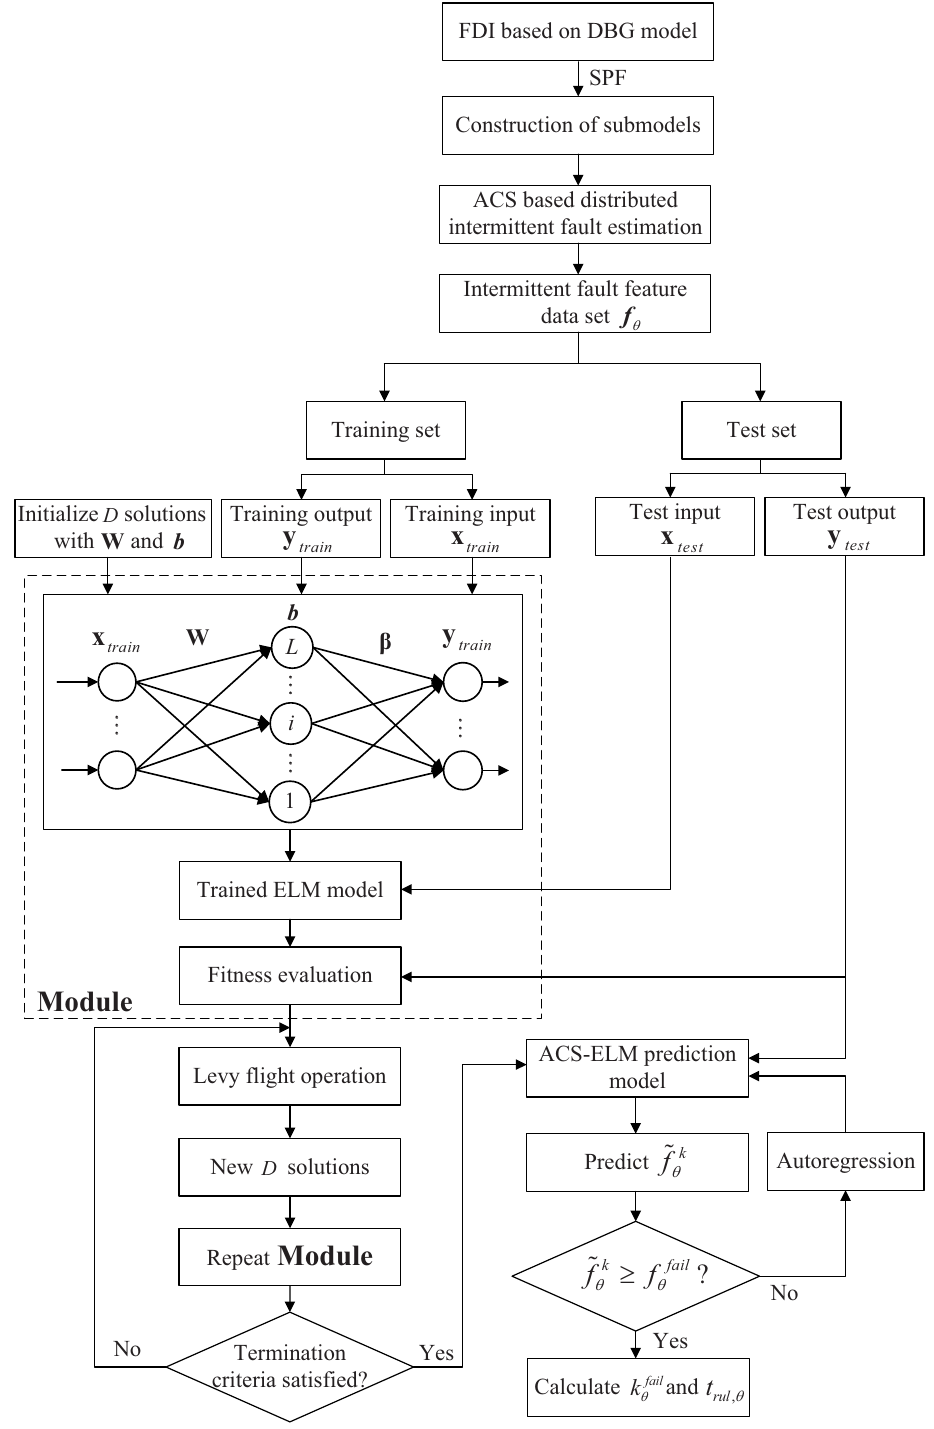
Figure 4. The framework of ACS-ELM based prognosis under intermittent